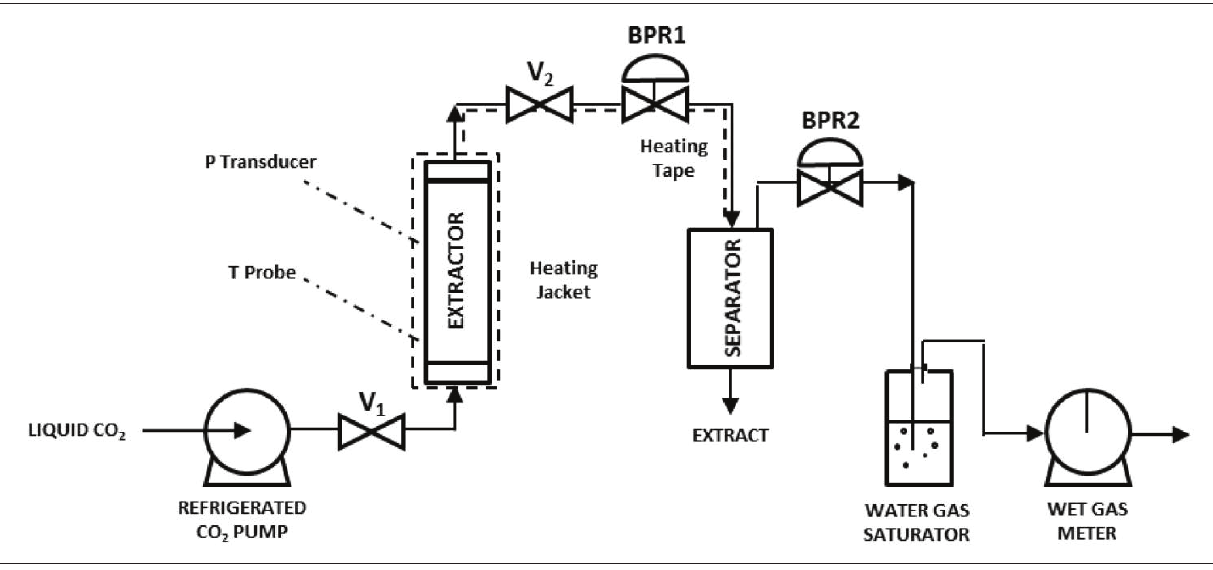
= on-off valves; BPRi = back-pressure regulators i